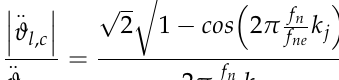
( f ; ( b ) sensitivity curve when